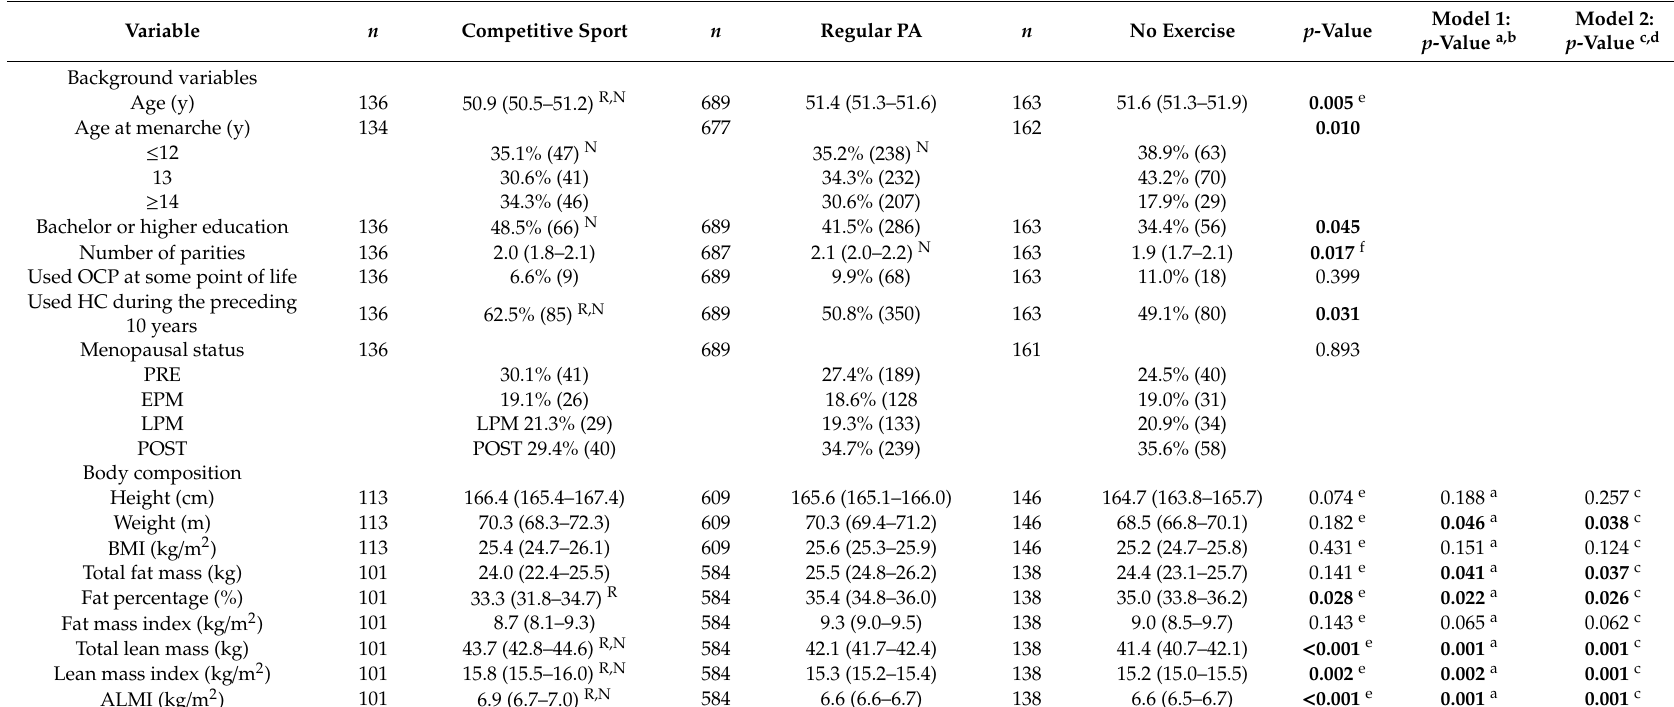
Table 2. Midlife characteristics of participants according to physical activity (PA) level at the age of